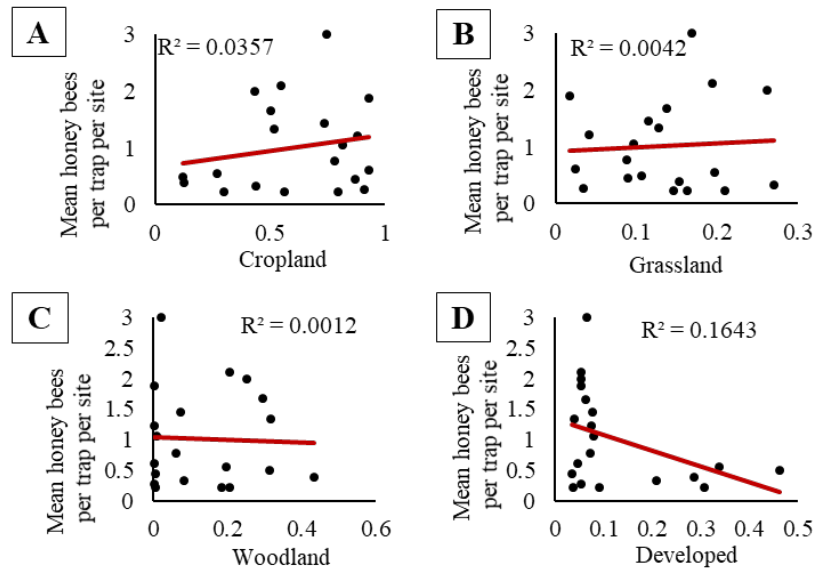
Figure 4. No significant relationships were found between honey bee activity-density (bees per trap per site) in pan traps with proportion of ( A ) cropland, ( B ) grassland, ( C ) woodland, nor ( D ) developed land cover within 1.6 km of the apiary at the field edge of soybean sites in 2015 and 2016.